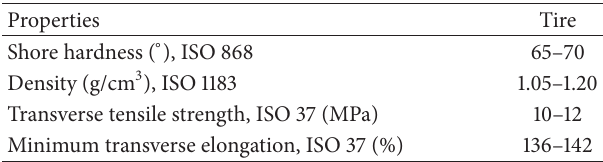
Table 1: Main physical and mechanical properties of the waste tires. Properties